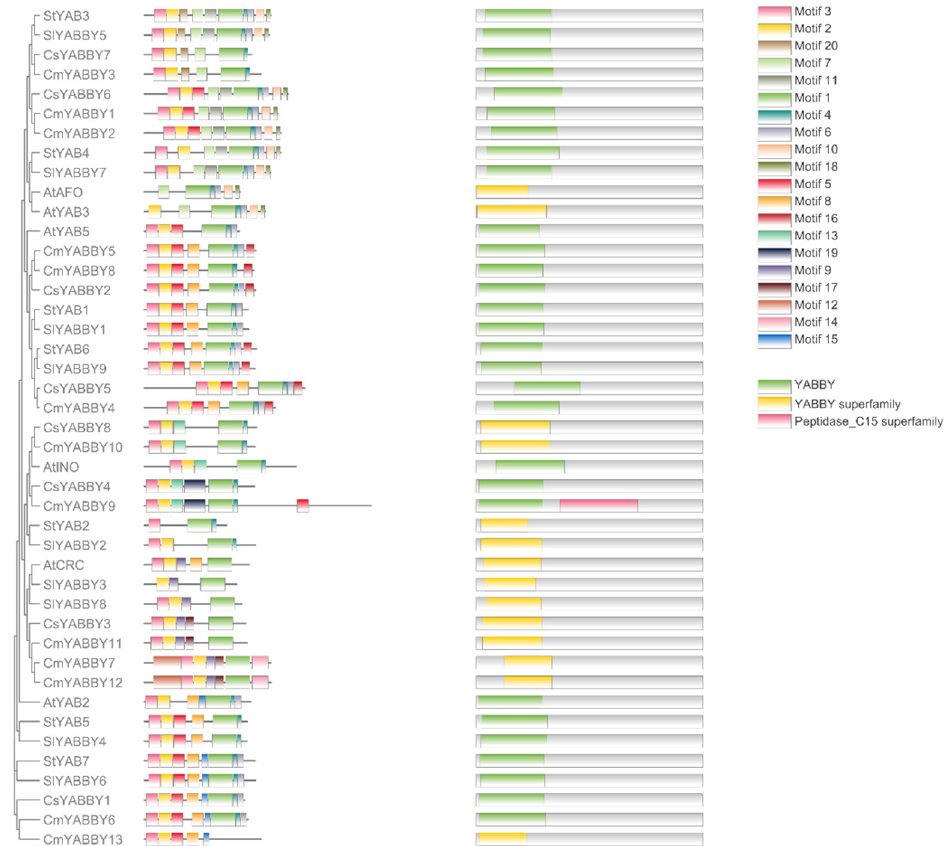
Figure 2. The distribution of 15 motifs on seven StYAB proteins. The motifs were found in potato by using MEME version 4.9.0 and inter-linking it with a phylogenetic tree to develop a good understanding of their association. The bars represent motifs with different color codes for the different types of motifs.